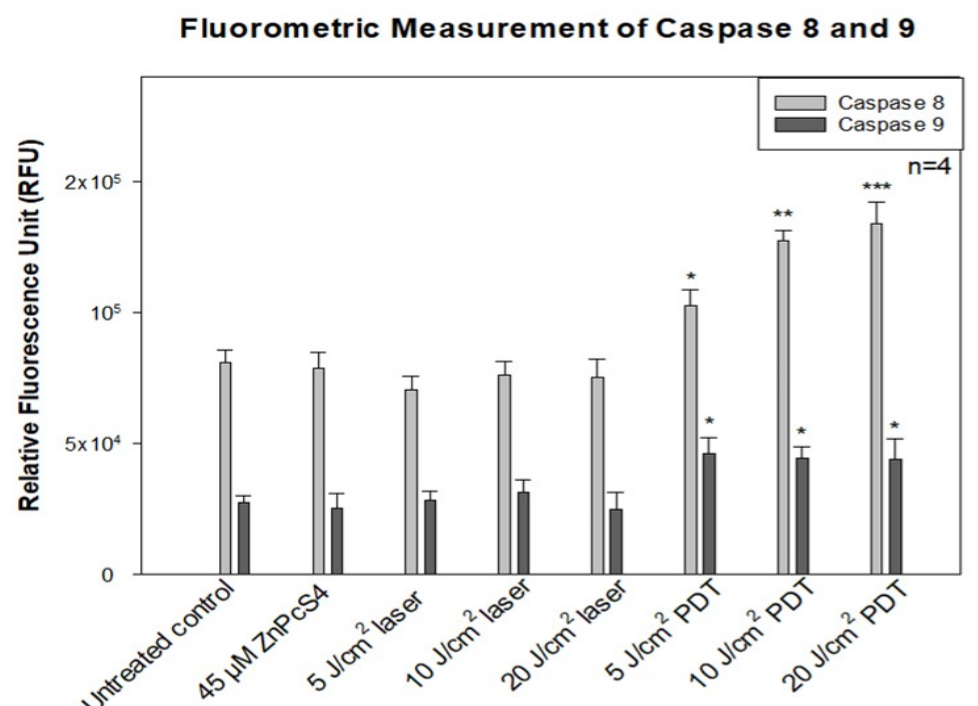
Figure 3. Fluorometric measurement of caspase 8 and 9 activities in MCF-7/DOX cells. The cellular photodamage induced by ZnPcS4-PDT significantly increased with * p < 0.01, ** p < 0.001, and *** p < 0.0006 the activities of caspase 8 in a fluence-dependent manner for 5, 10, and 20 J/cm 2 , respectively. Similarly, caspase 9 activity showed a significant ( p < 0.05) difference in all experimental groups compared to the untreated control. PS dark toxicity and laser controls showed no difference in comparison with the untreated control.